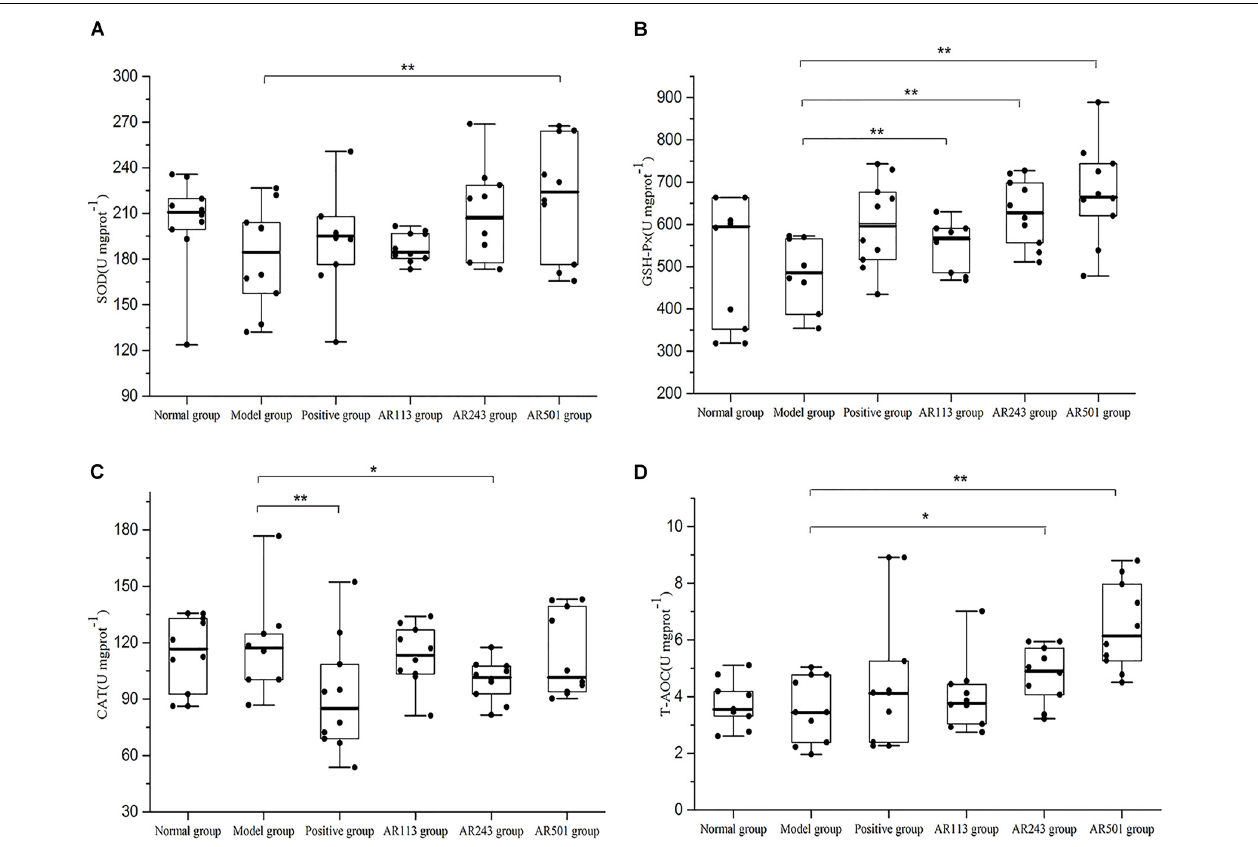
FIGURE 4 | Effect of LAB on oxidized oil induced changes in the activity of SOD (A) , GSH-Px (B) , CAT (C) , and T-AOC (D) in liver of mice. Where U/mgprot means the biological value of SOD, GSH-PX, CAT or T-AOC in per milligram protein in liver. Values are expressed as mean ± SD ( n = 10), ∗ p < 0.05 vs. model group, ∗∗ p < 0.01 vs. model